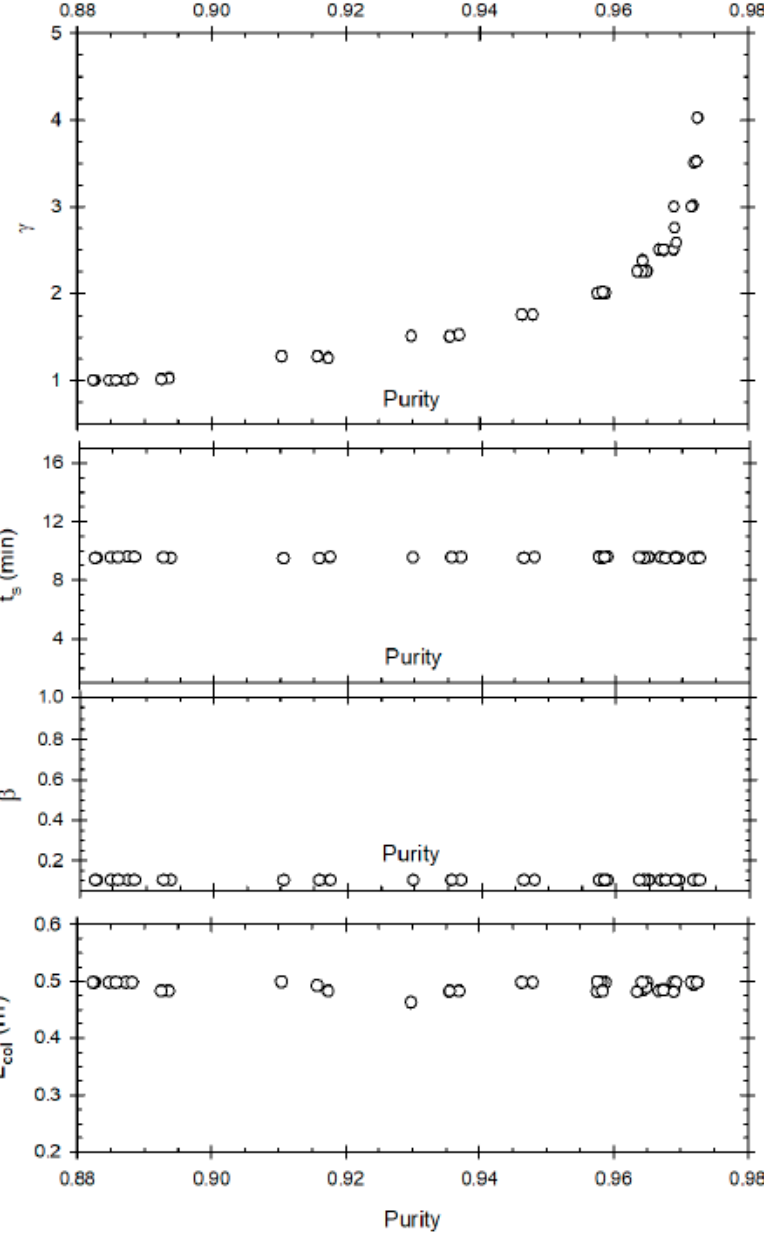
Figure 7. Case 2.2 Design-stage Optimization. Maximization of Purity and minimization of desorbent consumption. Pareto optimal solutions and corresponding operating variables.